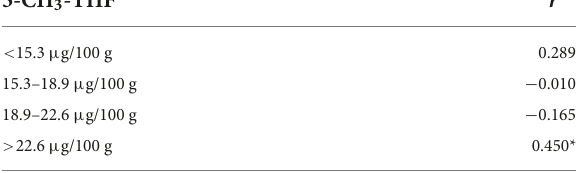
TABLE 1 Correlation analysis between the folate derivatives 5-CH 3 -THF and